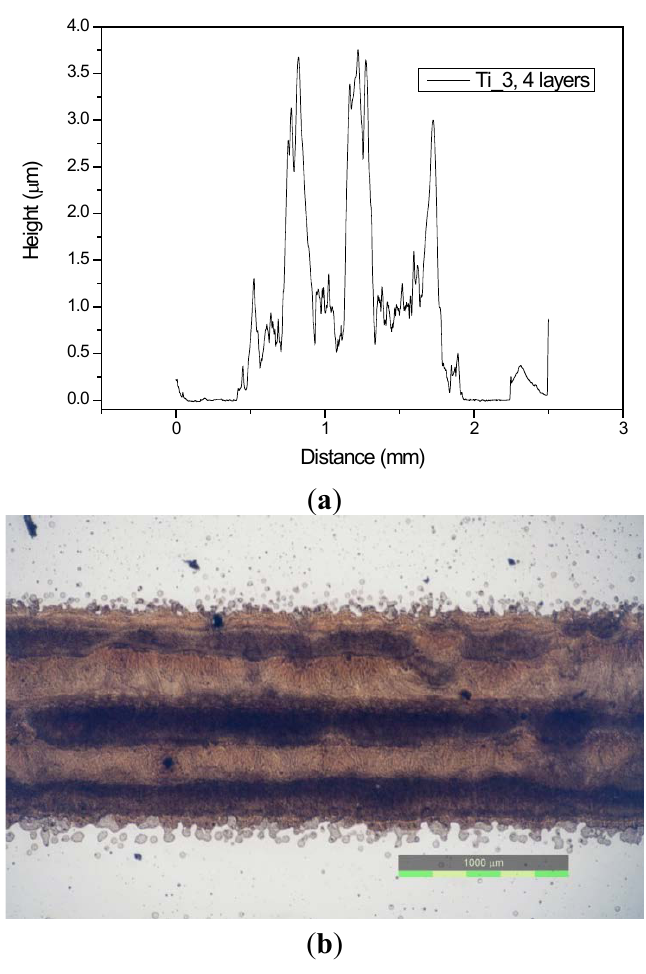
Figure 3. Banding patterns recorded in profilometric scan ( a ) and as seen in optical microscope ( b